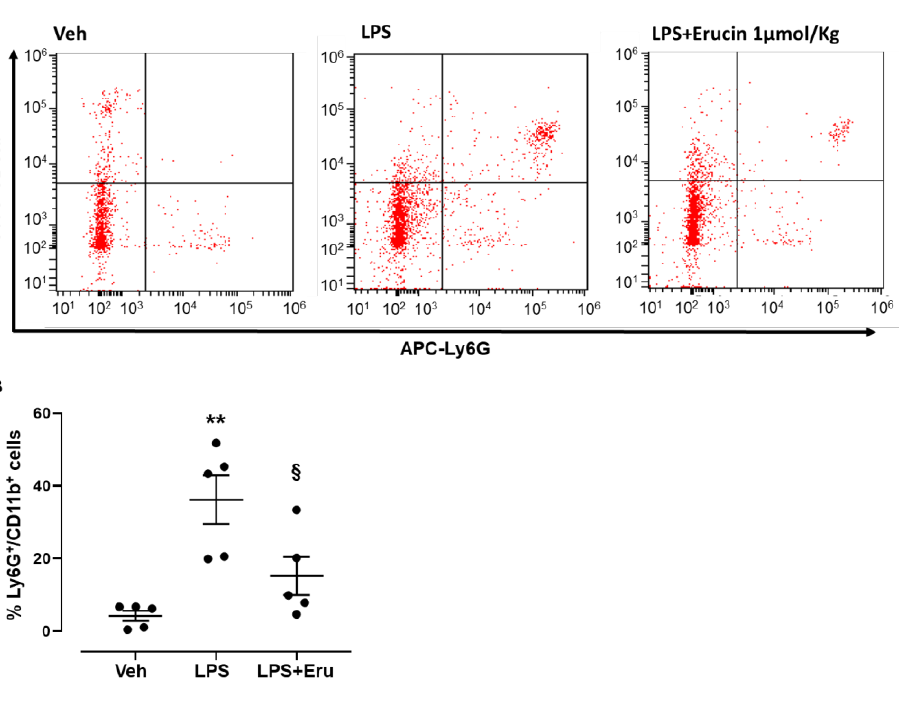
Figure 1. Preventive effects of erucin against LPS-induced neutrophil transmigration in murine peritonitis. Graphs show: ( A ) Representative dot plots following flow cytometry analysis indicating neutrophils as Ly6G+/CD11b+ double positive cells (upper right quadrant) in mice treated with LPS alone (0.1 mg/kg, 100 µL i.p.) or LPS+Erucin (1 µmol/kg, 100 µL i.p.) compared to control animals (Veh). ( B ) Scattered dot plot graph indicating % of Ly6G+/CD11b+ double positive cells peritoneal lavage following flow cytometry staining (n = 5). Results are shown as mean ± SEM. ** p < 0.01 vs. Veh. § p < 0.05 vs. LPS alone.